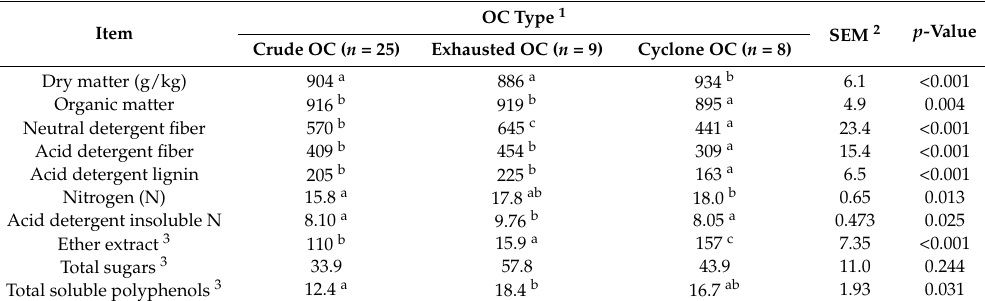
Table 2. Influence of olive cake (OC) processing on chemical composition (g/kg dry matter unless stated otherwise).